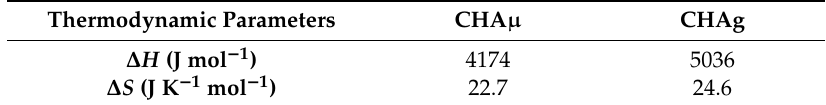
Table 5. Thermodynamic parameters of ∆ H and ∆ S for CHA µ and CHAg; see Section 2.6 for